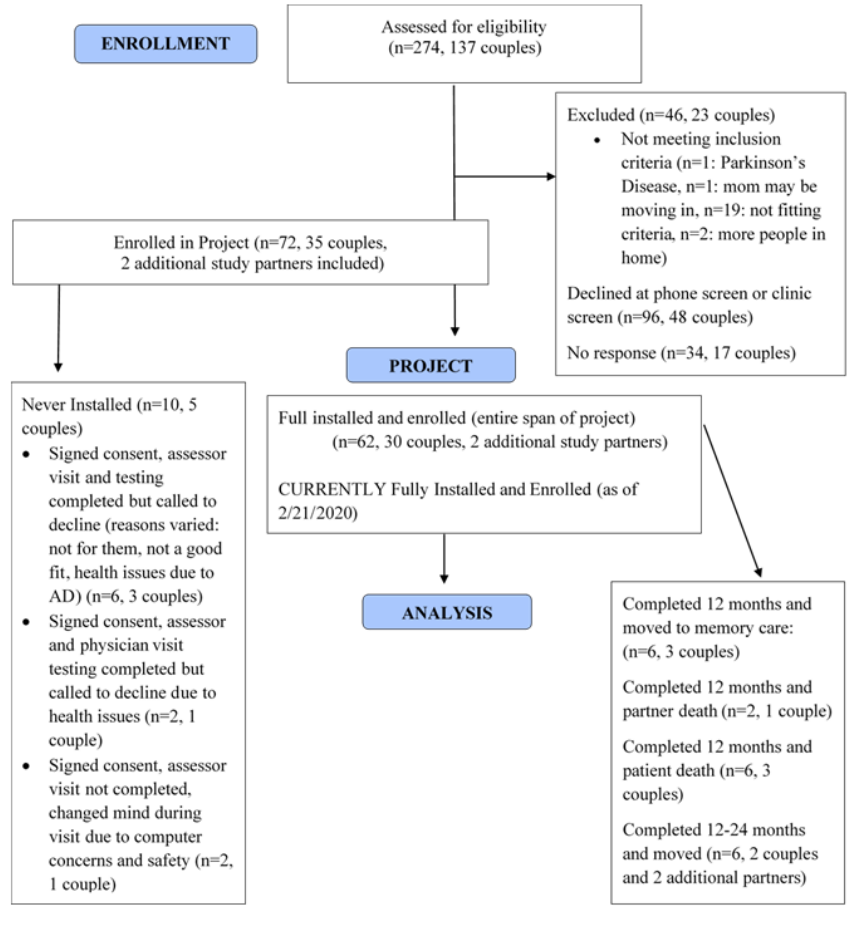
Figure 2. Participant enrollment and follow-up summary. Two homes were enrolled with a third additional study partner in the home, who also wore an activity monitoring wristwatch. AD: Alzheimer